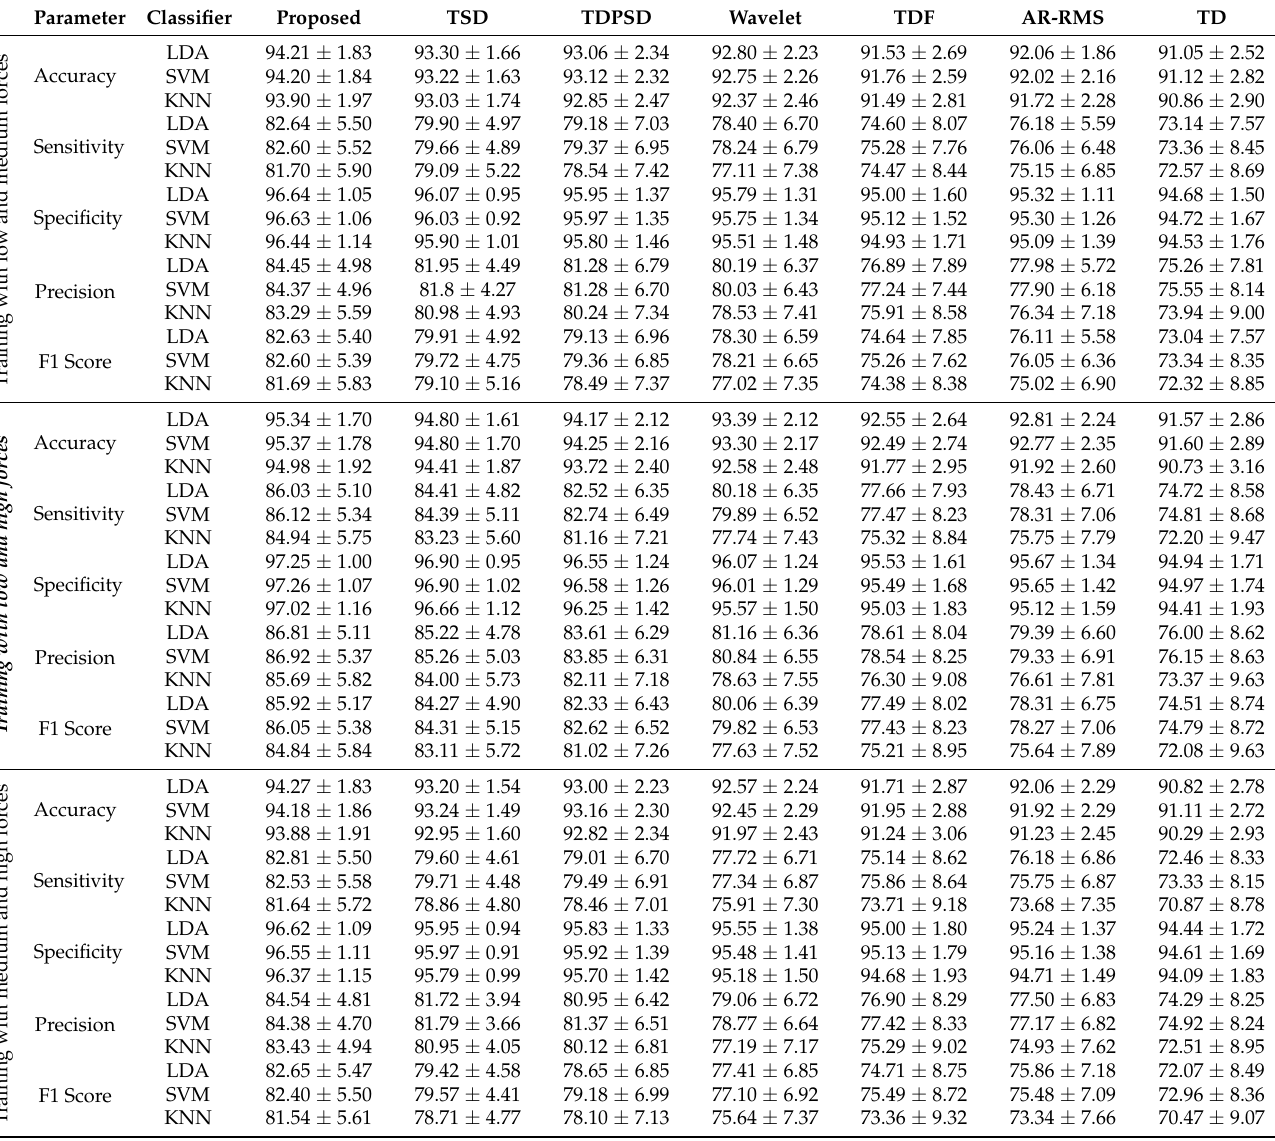
Table A3. The EMG pattern recognition performances when the classifiers are trained with two force levels and tested with all force